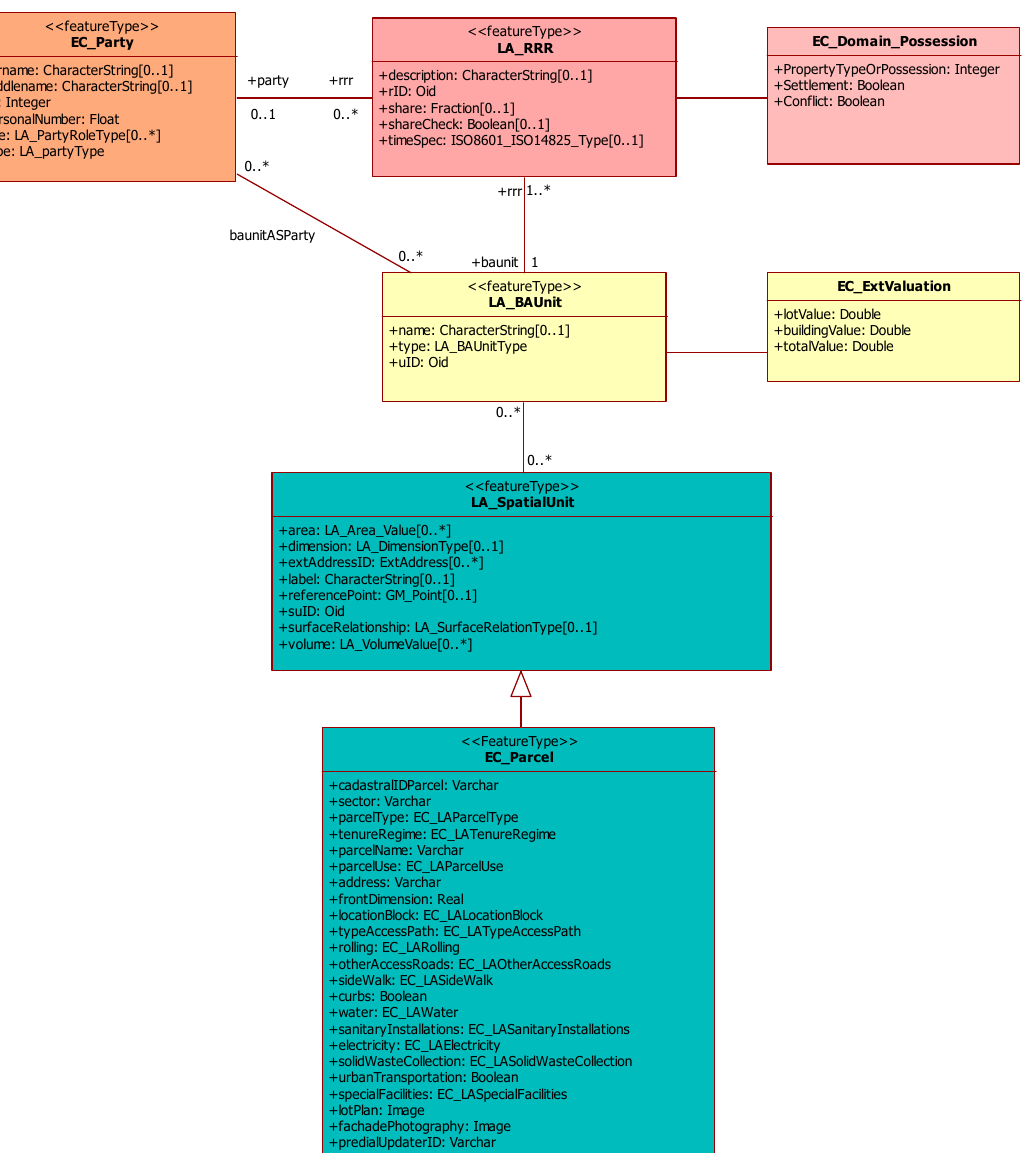
Figure 5. Initial Ecuadorian LADM country profile.